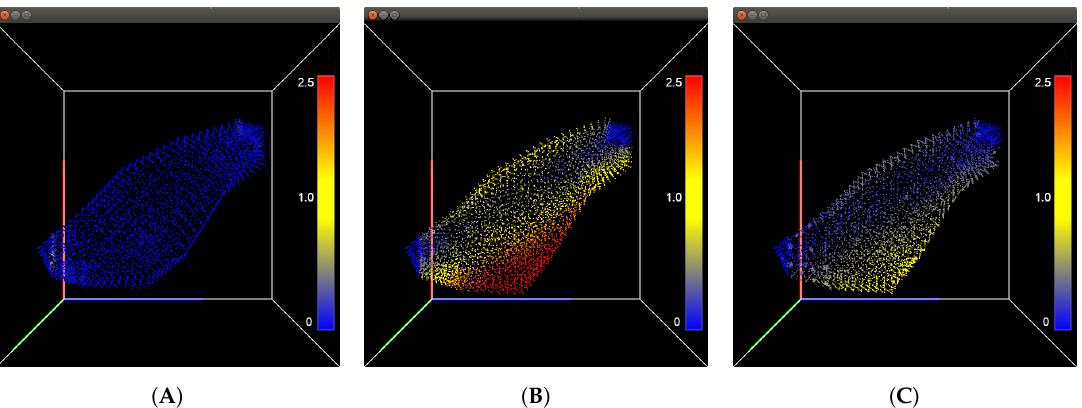
Figure 1. Integrated point-based tissue model for the triceps. ( A ) shows the initial state of the tissue, ( B ) shows the muscle after being innervated with a stimulus current, and ( C ) shows the muscle returning to its initial shape after the current was removed. The color of the particles represents its displacement with respect to its original position.